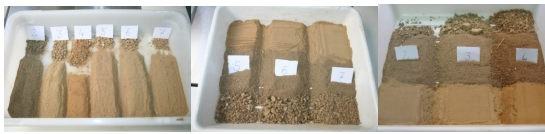
Table 2: Particle size characterization test results.